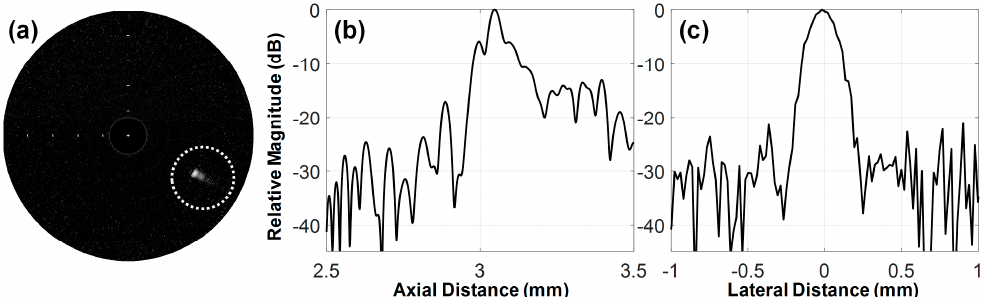
Figure 5. ( a ) Ultrasound B-mode image of a 25 µ m wire acquired at a focal depth of 3 mm, ( b ) the axial and ( c ) lateral beam profiles measured from the wire image indicated by a white dotted circle.